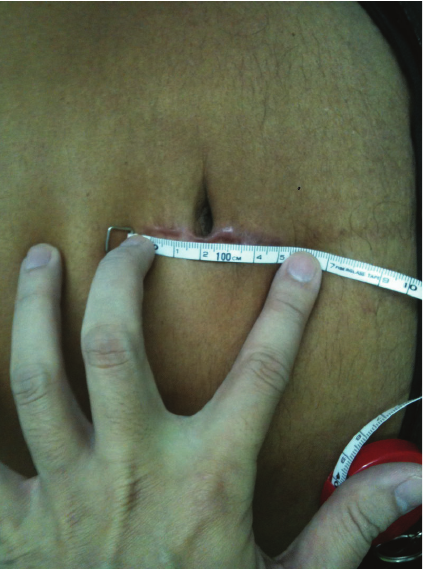
Figure 6: Postoperative wound